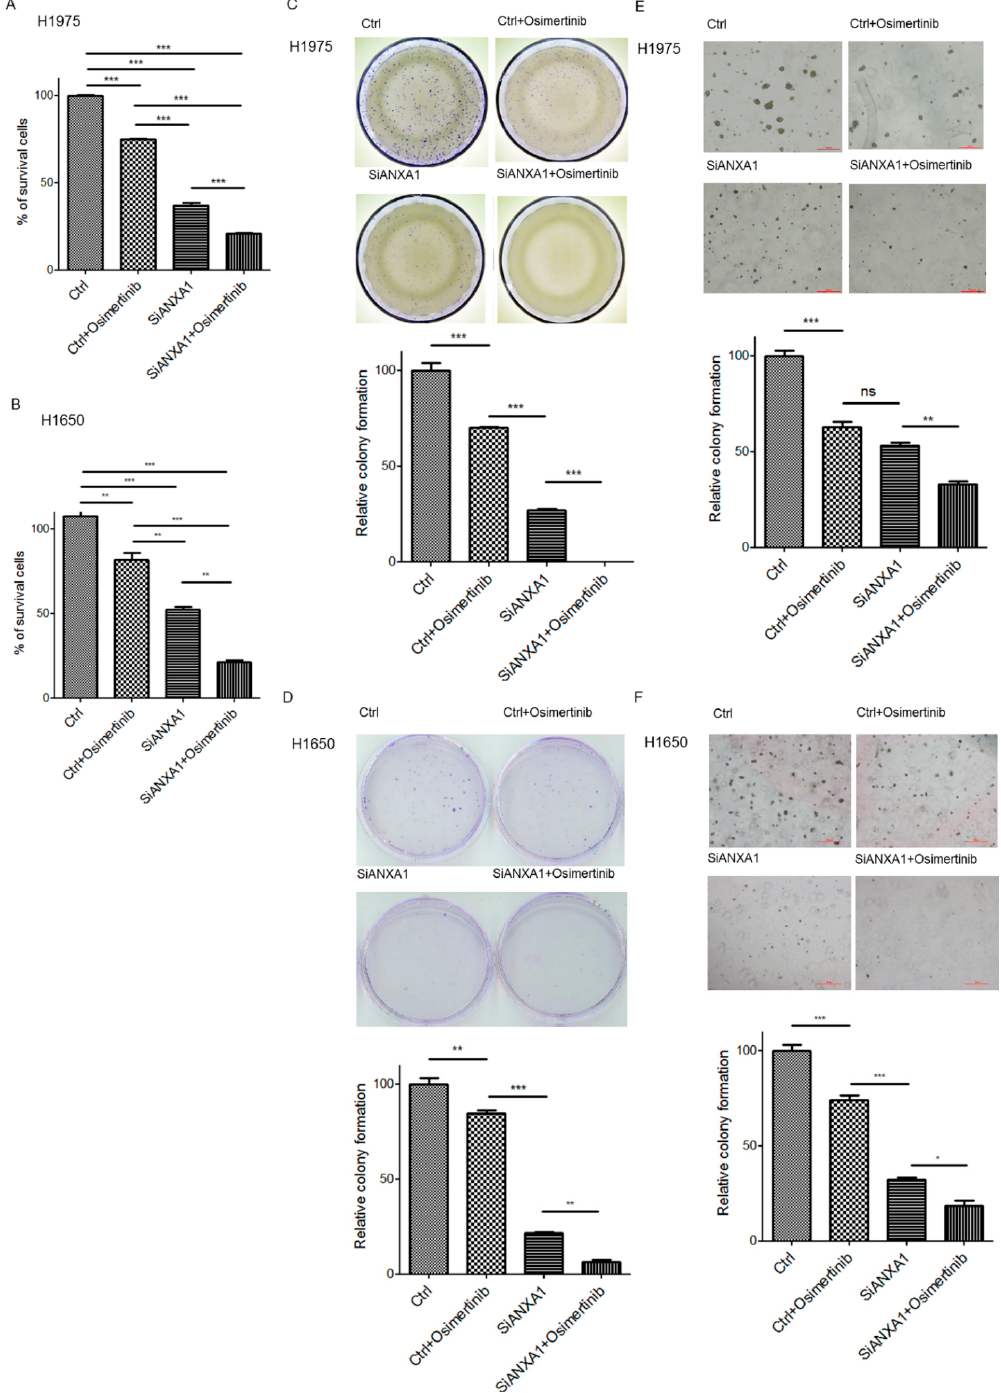
Figure 2. Cell numbers were determined in ( A ) H1975 and ( B ) H1650 lung cancer cells after transfection of 50 nM scrambled control (Ctrl) and ANXA1 (SiANXA1) siRNA with or without 10 nM Osimertinib for 72 h. Cell numbers were normalized to control siRNA transfected groups. The experiments were performed in triplicate. Anchorage-dependent colony formation assay in ( C ) H1975 and ( D ) H1650 lung cancer cells. After transfection of 50 nM scrambled control (Ctrl) and ANXA1 (SiANXA1) siRNA, cells were treated with or without 10 nM Osimertinib for 14 days. Anchorage-independent 3D culture in ( E ) H1975 and ( F ) H1650 lung cancer cells after transfection of 50 nM scrambled control (Ctrl) and ANXA1 (SiANXA1) siRNA with or without 10 nM Osimertinib for 10 days. Relative colony formation is represented by normalization of the colony number to the control group and shown as bar ± standard deviation in triplicate experiments. “ ns ” denotes nonspecific. “*” denotes p < 0.05; “**” denotes p < 0.01; “***” denotes p <